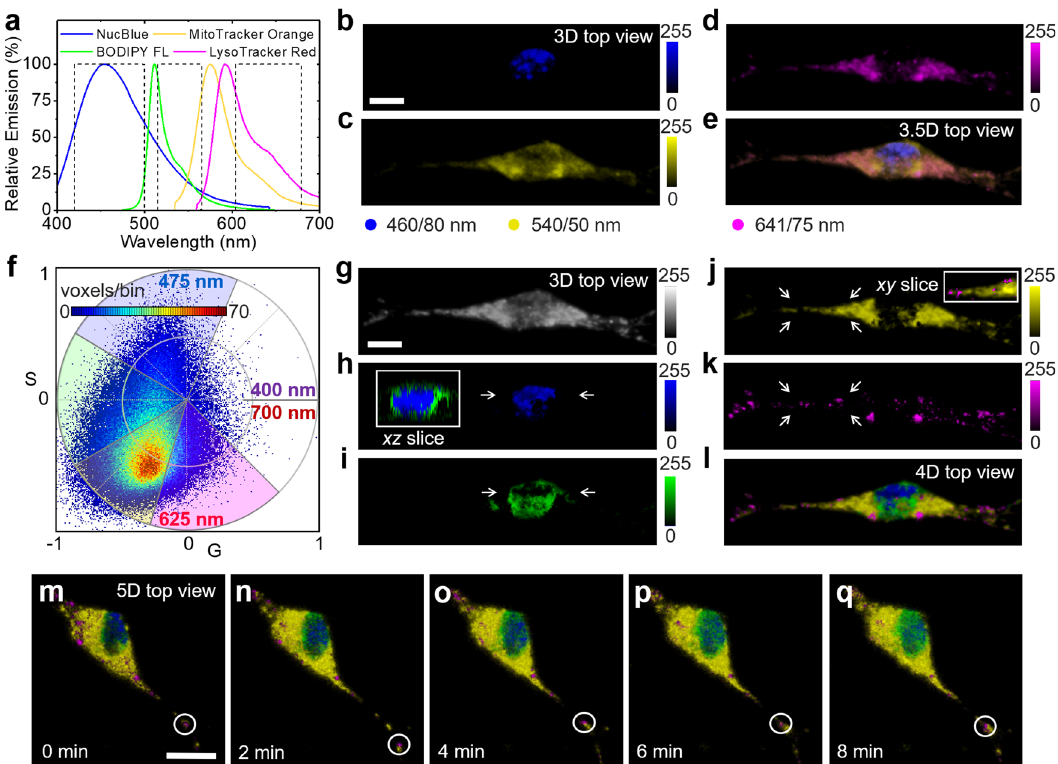
Fig. 5 5D imaging enables spectral separation and tracking of organelles in live cells. a The cell nucleus, Golgi, mitochondria, and lysosomes of NIH 3T3 cells were labeled with NucBlue, BODIPY FL, MitoTracker Orange, and LysoTracker Red (dye spectra raw data, Invitrogen) before ultrafast hyperspectral light sheet imaging with sine/cosine fi lters. b – e MIPs of 3D data and their overlay obtained by imaging in three spectral windows with bandpass fi lters (3.5D: 3D in channels DAPI, FITC, TexasRed, dashed lines in a ; this conventional approach was unable to discern between Goligi, mitochondria, and lysosomes. f Spectral phasor plot obtained by fl uorescence collection though sine/cosine fi lters of the same cell. g Total 3D MIP. h – k Unmixed MIPs color coded with respect to their emission center of mass wavelengths as indicated in the phasor plot ( f ). l 4D overlay, spectral phasor analysis could clearly distinguish all four organelle types. Insets in h , j show single, color-merged xz/xy planes to illustrate the position of nucleus/Golgi and mitochondria/ lysosomes with respect to each other. m – q 5D ( x , y , z , λ , t ) hyperspectral time lapse sequence enabling lysosome tracking (white circles). All cell stains were excited simultaneously via two photon absorption at 870 nm. Representative cells from three imaging sessions on three different days. Scale bars, 10 µ